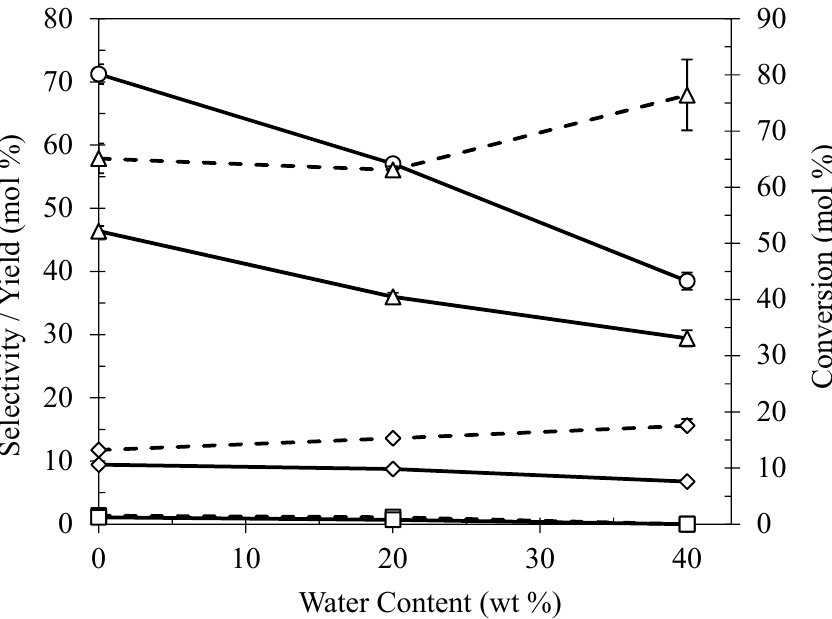
Figure 5. Effect of initial water content on the activity of 25 wt % Ni/Ce–Mg (9:1 mol/mol) catalysts prepared by DP and calcined at 350 °C. Reaction conditions: reactant 60 g glycerol, 10 g catalyst, hydrogen initial pressure pH 2 = 6.9 MPa (initial), and reaction time t = 24 Legend: solid lines for glycerol conversion and product yields, dashed lines for product selectivity, ( ○ ) glycerol conversion, ( ) ethanol, ( □ ) n -propanol, ( ) 1,2-PDO. Error bars are based on